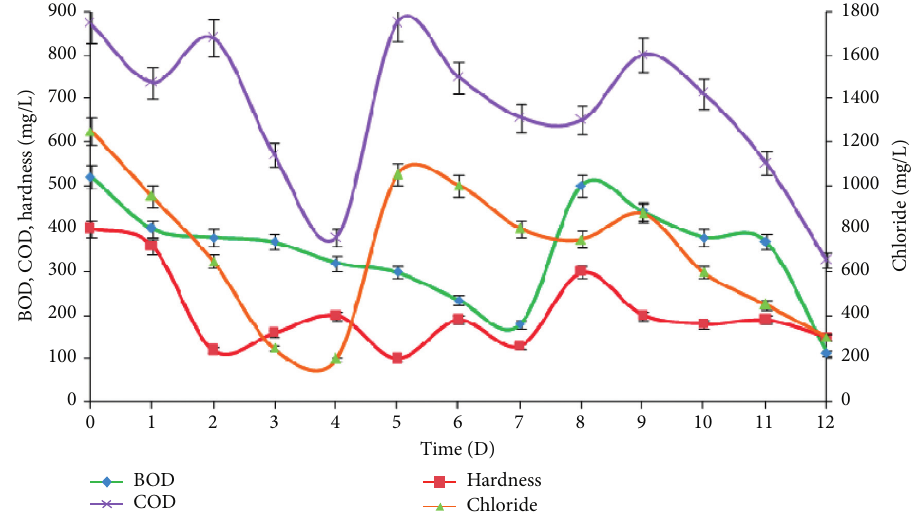
Figure 6: Removal of COD, BOD, chloride, and hardness in the anaerobic treatment of synthetic textile effluent containing 500mg/L of mixed azo dyes in An-SBR.